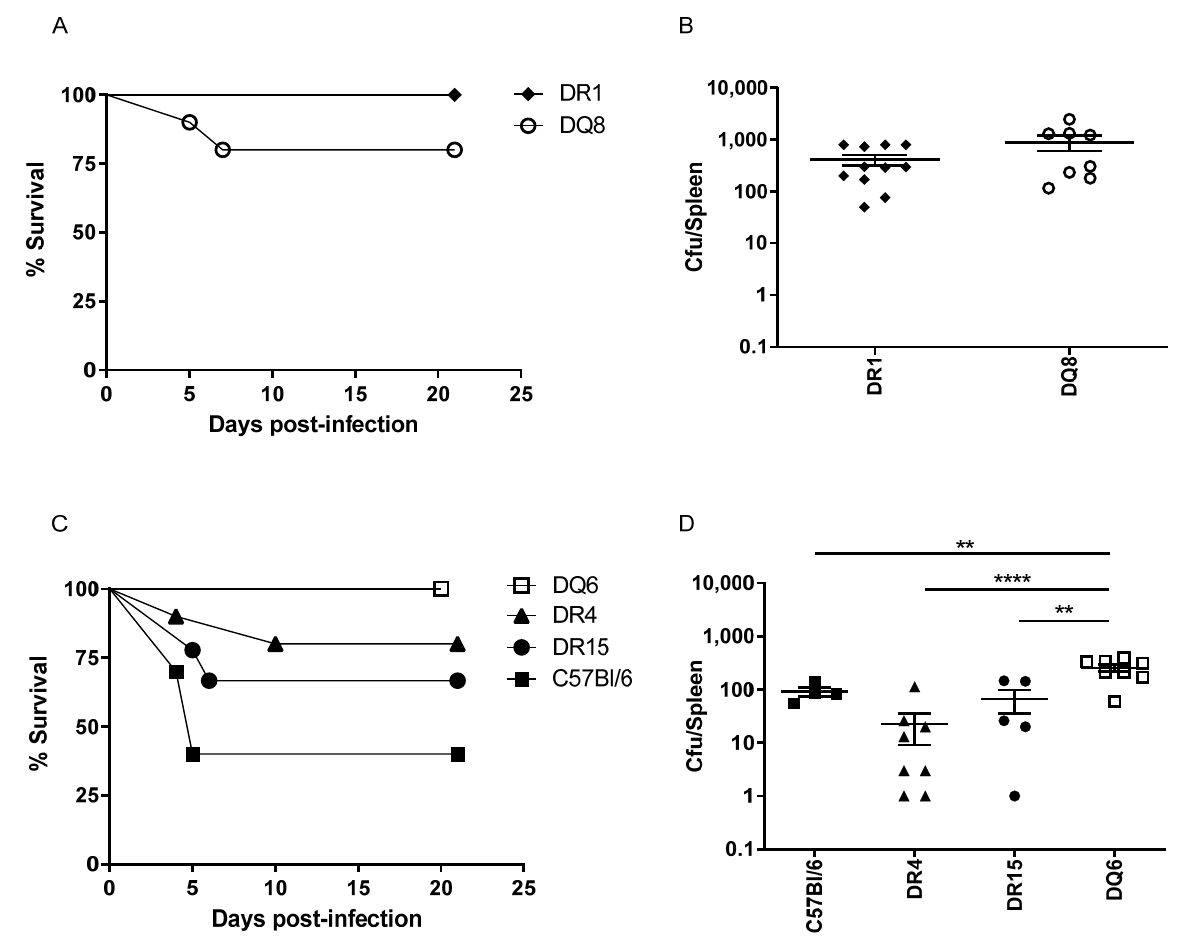
Figure 2. Differential susceptibility of HLA class II transgenic mice to anthrax infection. Groups of naïve HLA transgenic (DR1 n = 11, DQ8 n = 10, DR15 n = 9, DR4 n = 10, DQ6 n = 8) or C57Bl6 (n = 10) mice were challenged with either 10 5 ( C , D ) or 10 6 ( A , B ) CFU B. anthracis STI strain, in order to compare susceptibility. Mice were challenged intraperitoneally and their survival observed for 20 days post-infection. Percentage survival, together with mean splenic bacterial counts per HLA type, is shown for mice succumbing within the observation period (days 1 to 19) and for survivors culled at day 20. Statistical comparison of mean bacterial loads by mouse strain ( D ) indicated that higher bacterial loads were seen in DQ6 in comparison to; C57BL/6 (** p = 0.0093), DR4 (**** p < 0.0001)